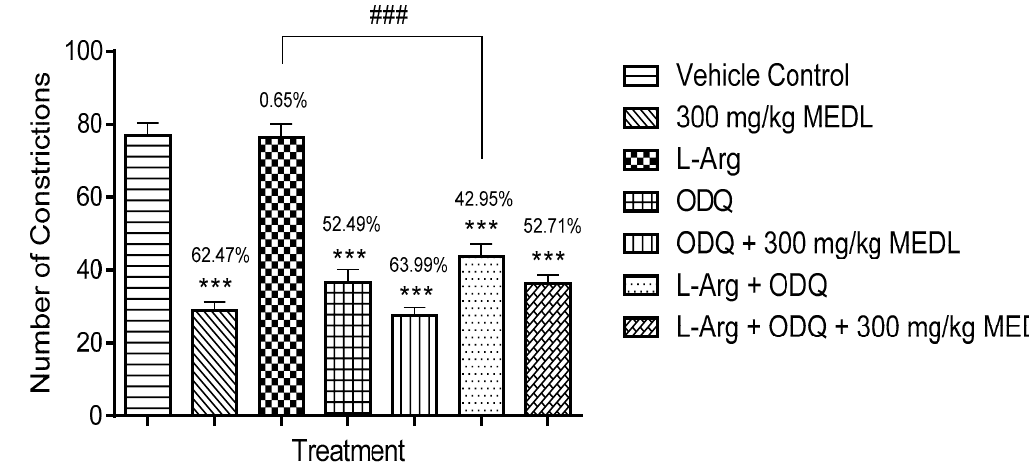
Figure 9. Effects of ODQ on MEDL against acetic acid–induced abdominal constriction test in mice. Each column represents the mean ± SEM of six mice. Statistical analyses were performed using 1-way ANOVA followed by Tukey’s multiple comparisons test. *** p ≤ 0.001 compared to vehicle control group; ### p ≤ 0.001 compared to L -arginine-treated group. Values on top of each column denote inhibition.